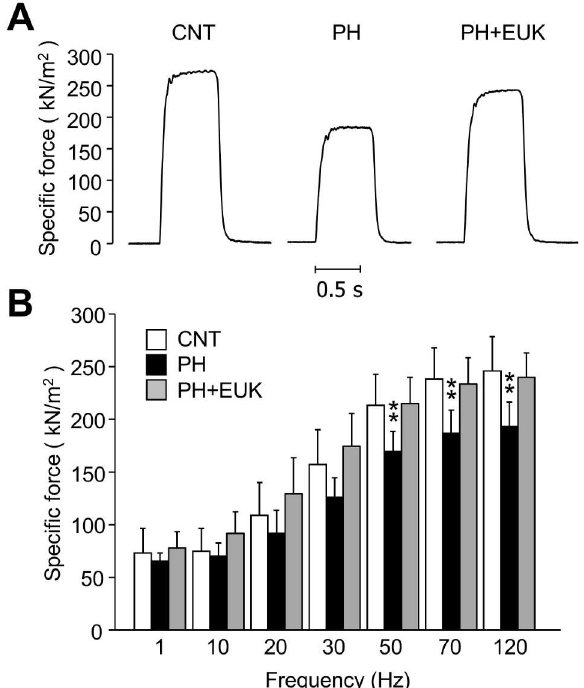
Fig 3. Antioxidant treatment prevents contractile dysfunction in PH diaphragm muscles. A : typical examples(120 Hz stimulationfrequency, 600 ms train duration)of specific force in diaphragmfiber bundles from CNT and PH rats with or without EUK-134 (EUK) treatment. B : specific force-frequency relationship. Data show mean ± SD for 7–10 rats in each group. ** P < 0.01 vs .